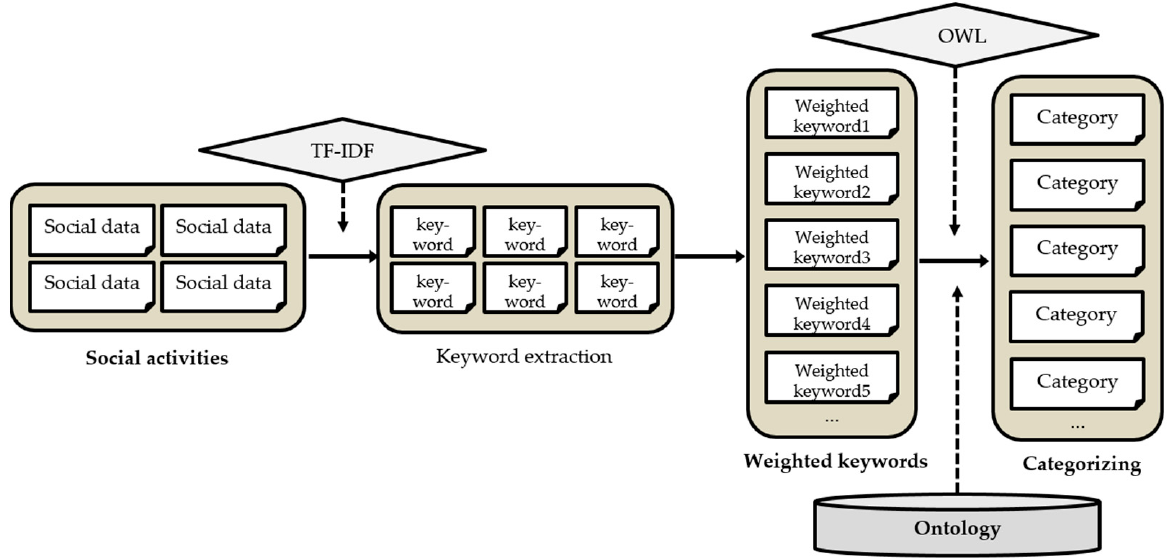
Figure 2. Procedure of user preference determination.